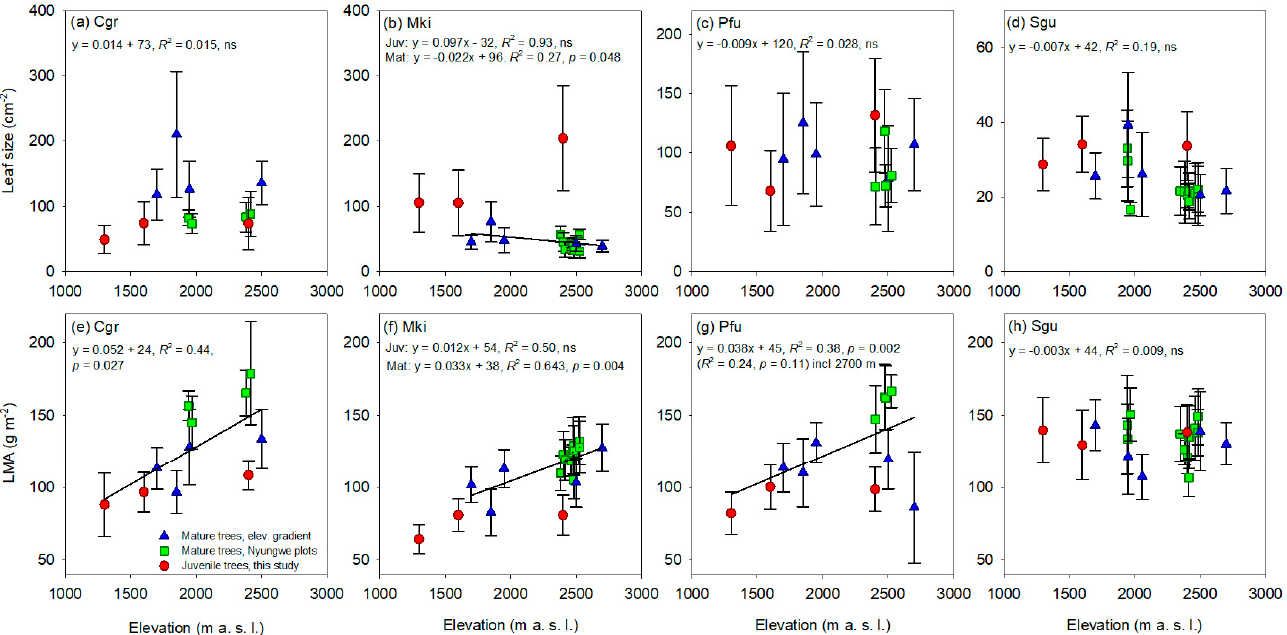
Figure 7. ( a – h ) Leaf size and leaf mass per area unit (LMA) at different elevations for Cgr, Carapa grandiflora ( a , e ); Mki, Macaranga kilimandscharica ( b , f ); Pfu, Polyscias fulva ( c , g ); Sgu, Syzygium guineense ( d , h ) in three independent studies in Rwanda. Each data point shows mean ± SD at each site included in the studies. Blue triangle, mature-tree elevation-gradient study; green square, permanent monitoring plots in Nyungwe forest with mature trees; red circle, elevation-gradient study with juvenile trees (Rwanda TREE, this study); lines, equation and R 2 represents the regression line for all tree studies. p -value refers to the slope coefficient. Table 5. p -values for effect of tree age (juvenile and mature trees) on leaf size and leaf mass per area unit (LMA) of four species along elevation gradients using elevation as a covariate and standardised to 2000 m a.s.l (common for all gradients). The elevation effect was analysed by regression analysis, and for significant age * elevation interaction, a separate regression analysis was conducted for each tree age class (Figure 7a–h). For full name of species, see Table 2. p -Values for